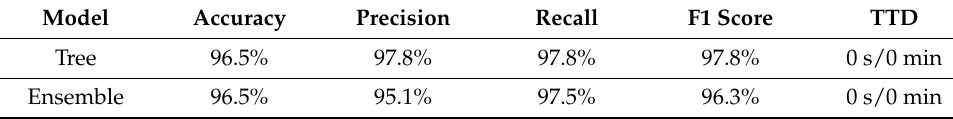
Figure 16. Experiment 4 approach. Table 6. Experiment 4